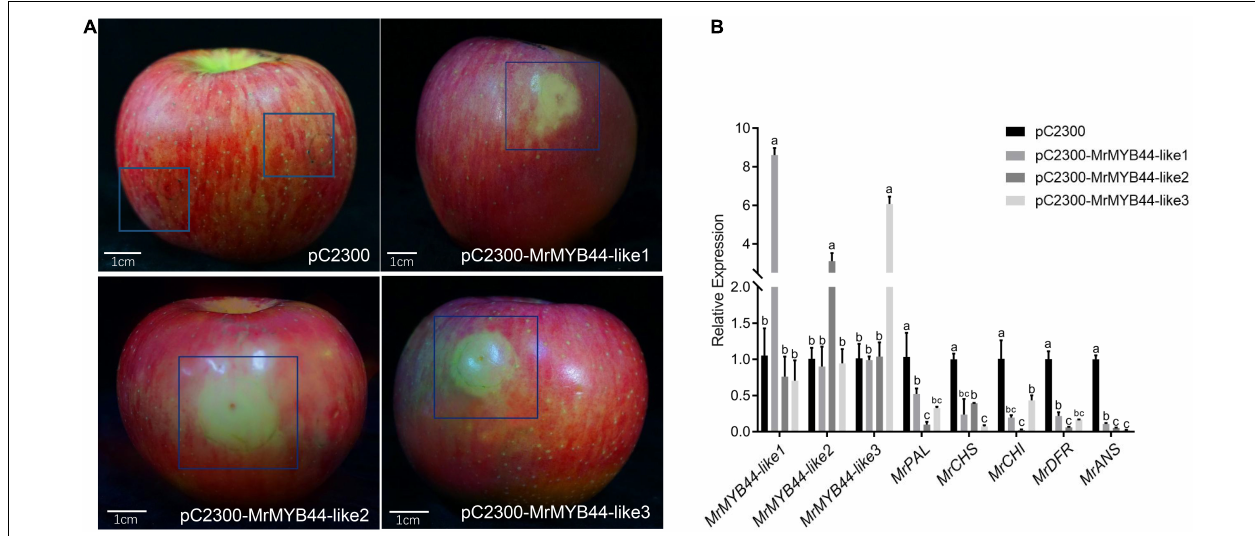
FIGURE 5 | MrMYB44-like s negatively regulate color formation in apple transformation assays. (A) Malus domestica ‘Fuji’ fruit peel coloration around injection sites. pC2300-MYB44-likes were used for overexpression with the pCambia2300 vector. Empty vectors were the control. (B) Transcript levels of MrMYB44-like s and other anthocyanin biosynthesis genes in M . domestica ‘Fuji’ fruit peel around injection sites. Values were calculated relative to the transcription level of the control (set to one). Error bars represent the standard errors. Different lowercase letters indicate significant differences among treatments according to one-way ANOVA test ( P < 0.05).